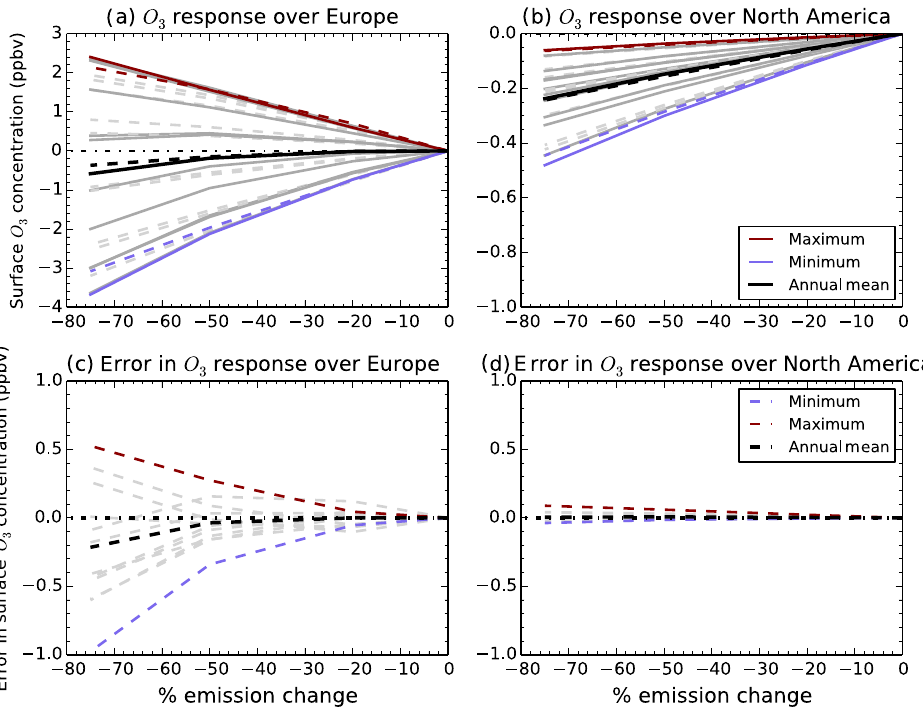
Figure 2. Sensitivity of monthly surface O 3 changes in HadGEM2-ES (solid lines) and that of the parameterised response using solely HadGEM2-ES as input (dashed lines) to 20, 50 and 75% reductions in all precursor emissions over the European source region (a) and the remote receptor region of North America (b) . The difference (error) between HadGEM2-ES and the parameterised response is shown over Europe (c) and North America (d) . Annual mean values are in black with monthly responses in grey, and the highest and lowest months are highlighted in red and